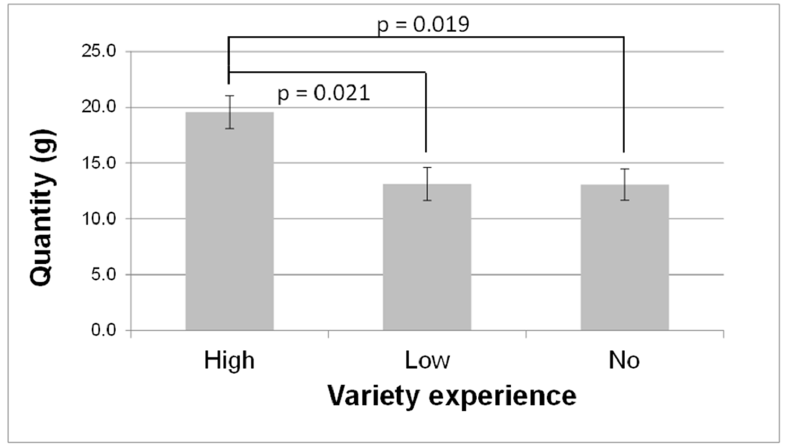
Fig 6. Early experience with high variety of vegetables is associated with higher intake of familiar vegetables. Intake (mean ± SE, in grams) at follow-up 3, i.e. when children were on average 6 years old, for the three experimental groups (no, low and high